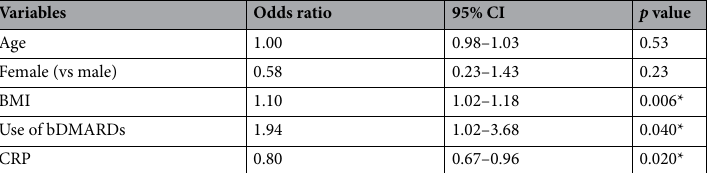
Table 2. Multivariate logistic regression analysis to determine the factors associated with the classification of knee radiographs into the OA-like RA group. *The level of statistical significance was set at p <